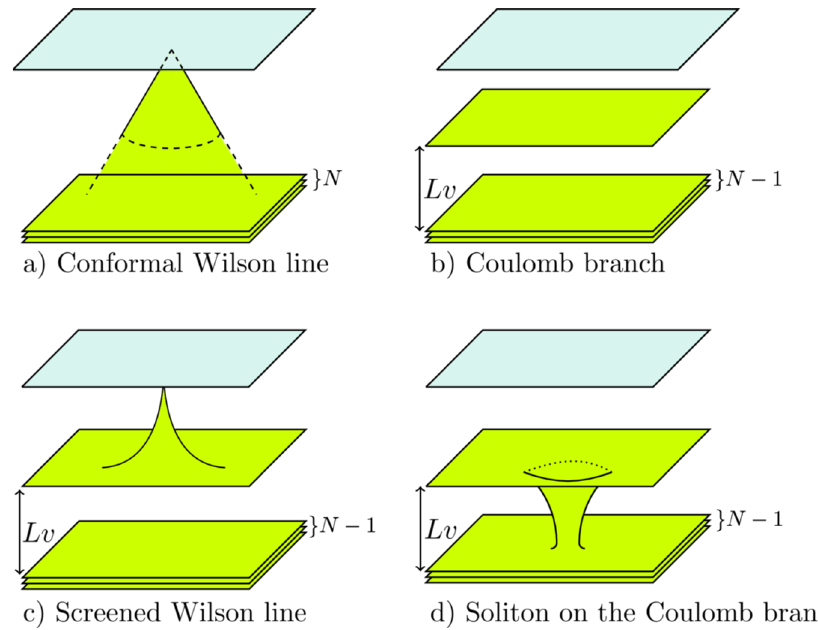
Figure 1 . Cartoons of the D3-brane solutions discussed in the paper. The green surfaces depict the D3-branes, while the pale blue planes represent the conformal